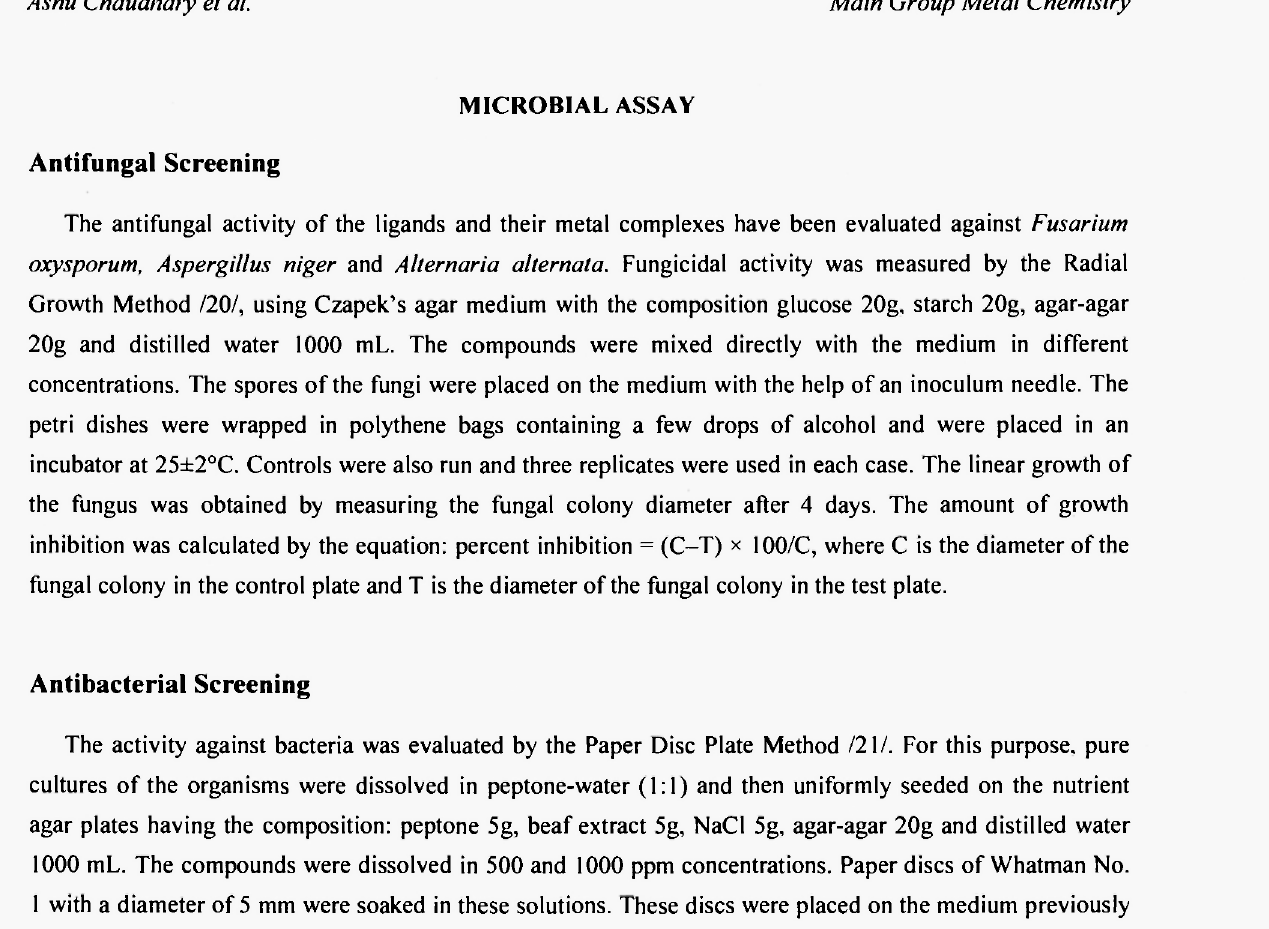
Antifungal activity of the ligands and their corresponding metal